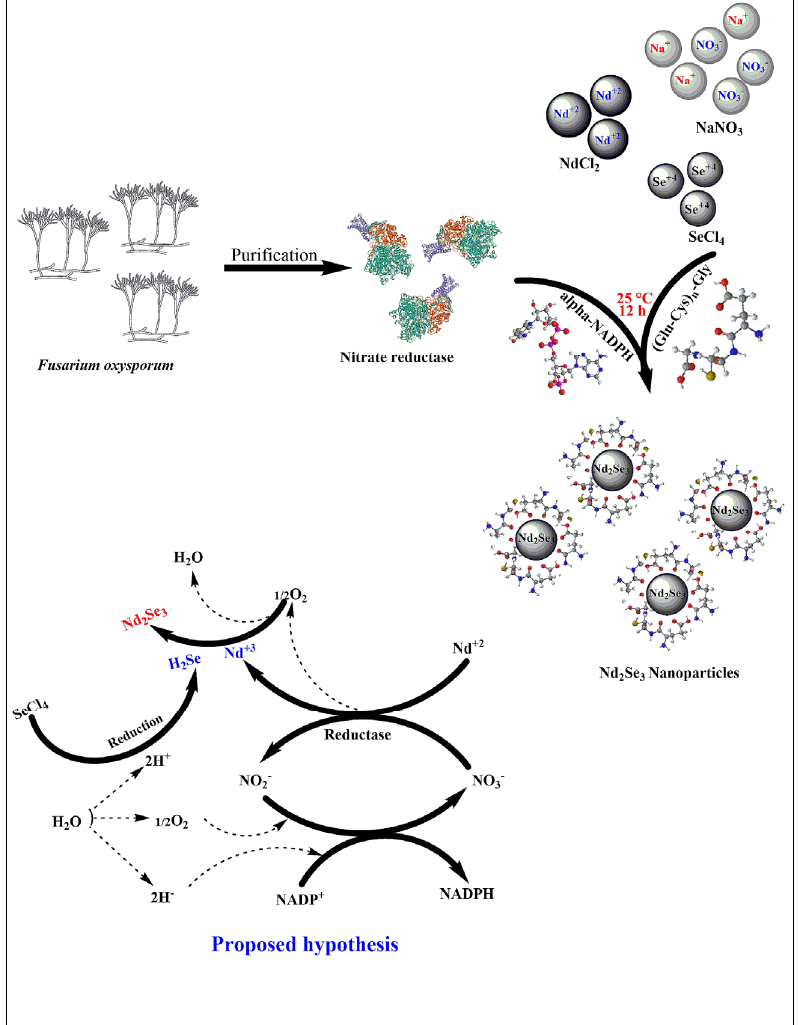
Figure 1. Schematic representation for synthesis of neodymium nanoparticles and proposed mechanism.